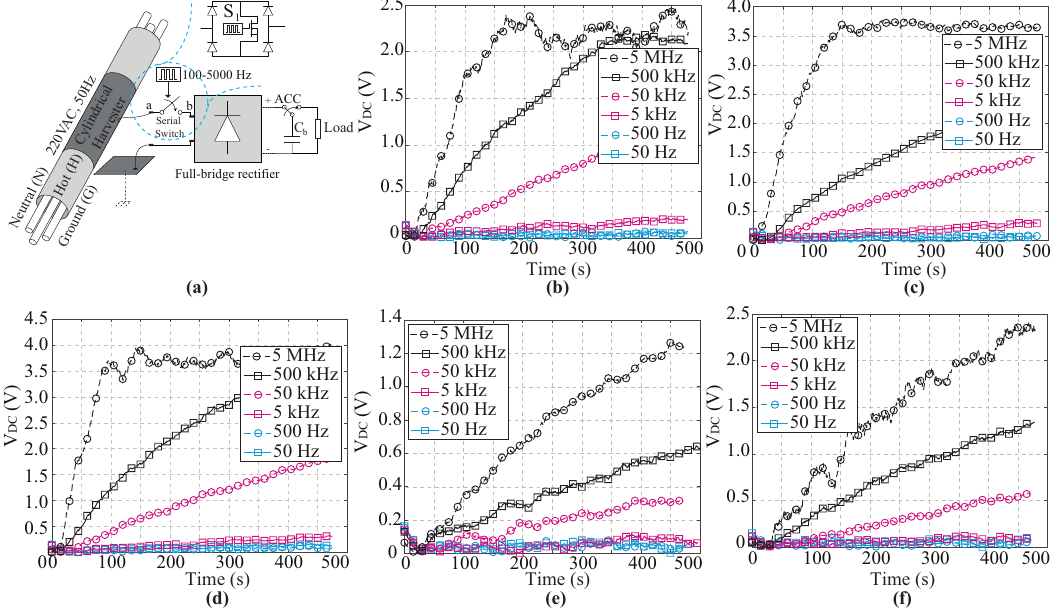
Figure 8. Frequency analysis; ( a ) representative depiction of the EFEH concept; ( b ) charging pattern of C b under the open-circuit conditions with sheath length of 10 cm and square voltage source; ( c ) charging pattern of C b under the open-circuit conditions with sheath length of 30 cm and sinusoidal voltage source; ( d ) charging pattern of C b under the open-circuit conditions with sheath length of 30 cm and square voltage source; ( e ) charging pattern of C b under the open-circuit conditions with sheath length of 5 cm and sinusoidal voltage source; ( f ) charging pattern of C b under the open-circuit conditions with sheath length of 5 cm and square voltage